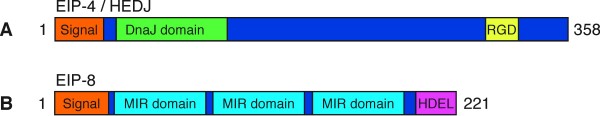
Structure of two endonuclein interacting proteins. (A) Endonuclein interacting protein 4, DNAJB11, contains a signal sequence that is putatively cleaved off between Ala-22 and Gly-23. It contains a DnaJ domain (green box) and an RGD sequence (yellow box) and might be secreted due to the lack of an ER retrieval sequence. (B) SDF2-like protein 1 contains a signal sequence that is putatively cleaved off between Ala-28 and Ala-29. It contains three MIR domains (blue box) and a HDEL ER retrieval sequence (purple box).